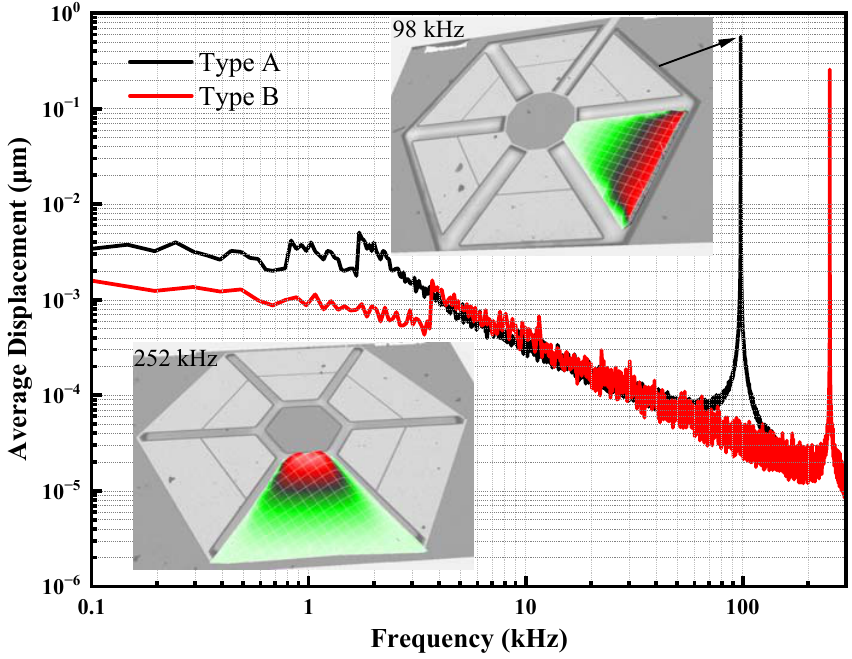
Figure 6. Frequency response measurement results using a Polytec MSA ‐ 600 LDV.